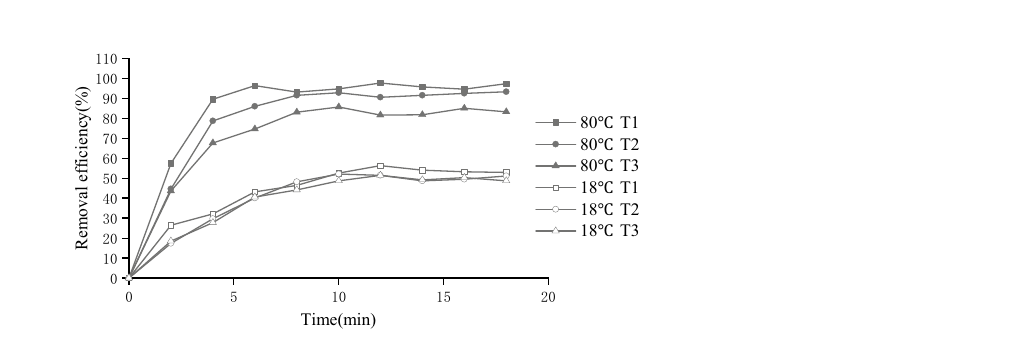
Figure 5. Pollutant extraction efficiency of thermally enhanced